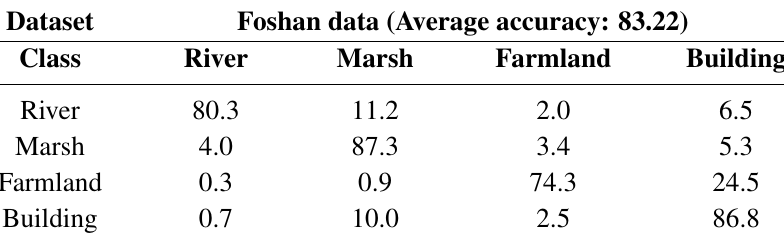
Table 7. Confusion matrix for the MAS + MRF result